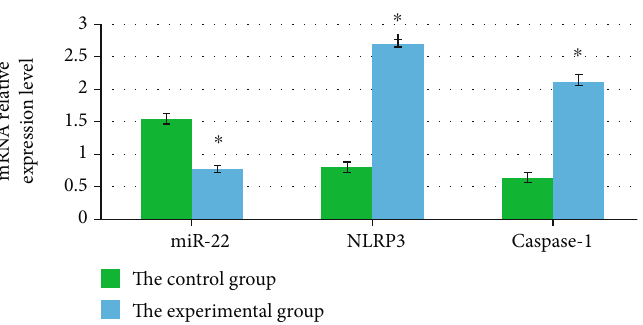
Figure 3: Levels of mRNA in miR-22, NLRP3, and caspase-1 ( ∗ indicated that the comparison with the control group showed P < 0 : 05 ).